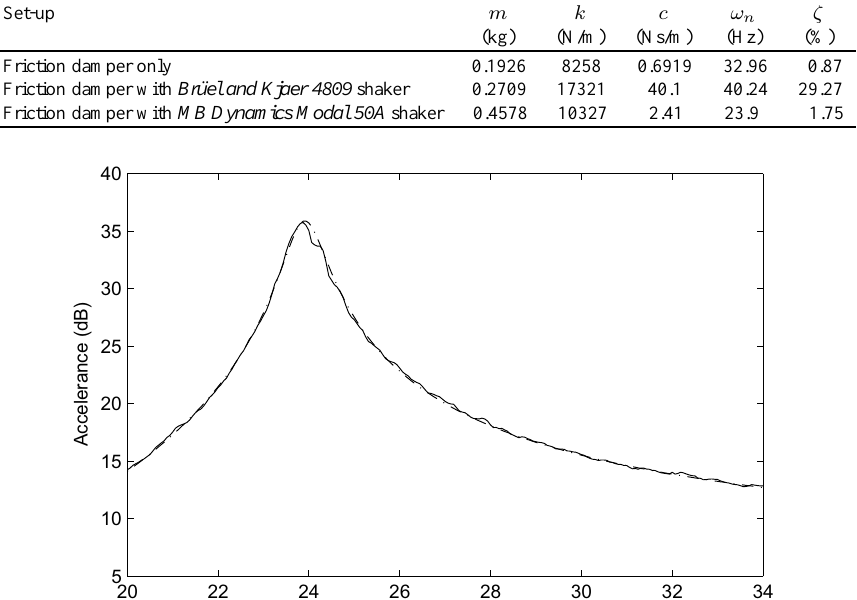
Table 2 Identified parameters for the SDOF systems, without any friction force